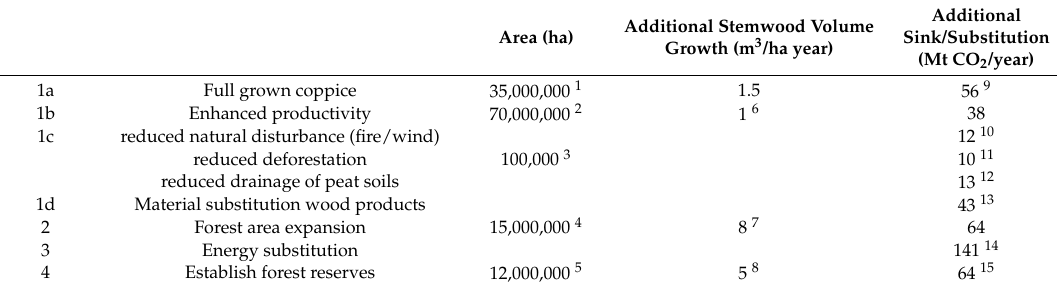
Table A2. Calculations Table, with Explanations in Footnote